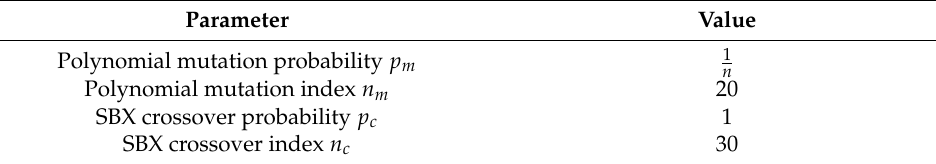
Table 2. Crossover and mutation parameters used for NSGA-III-P.